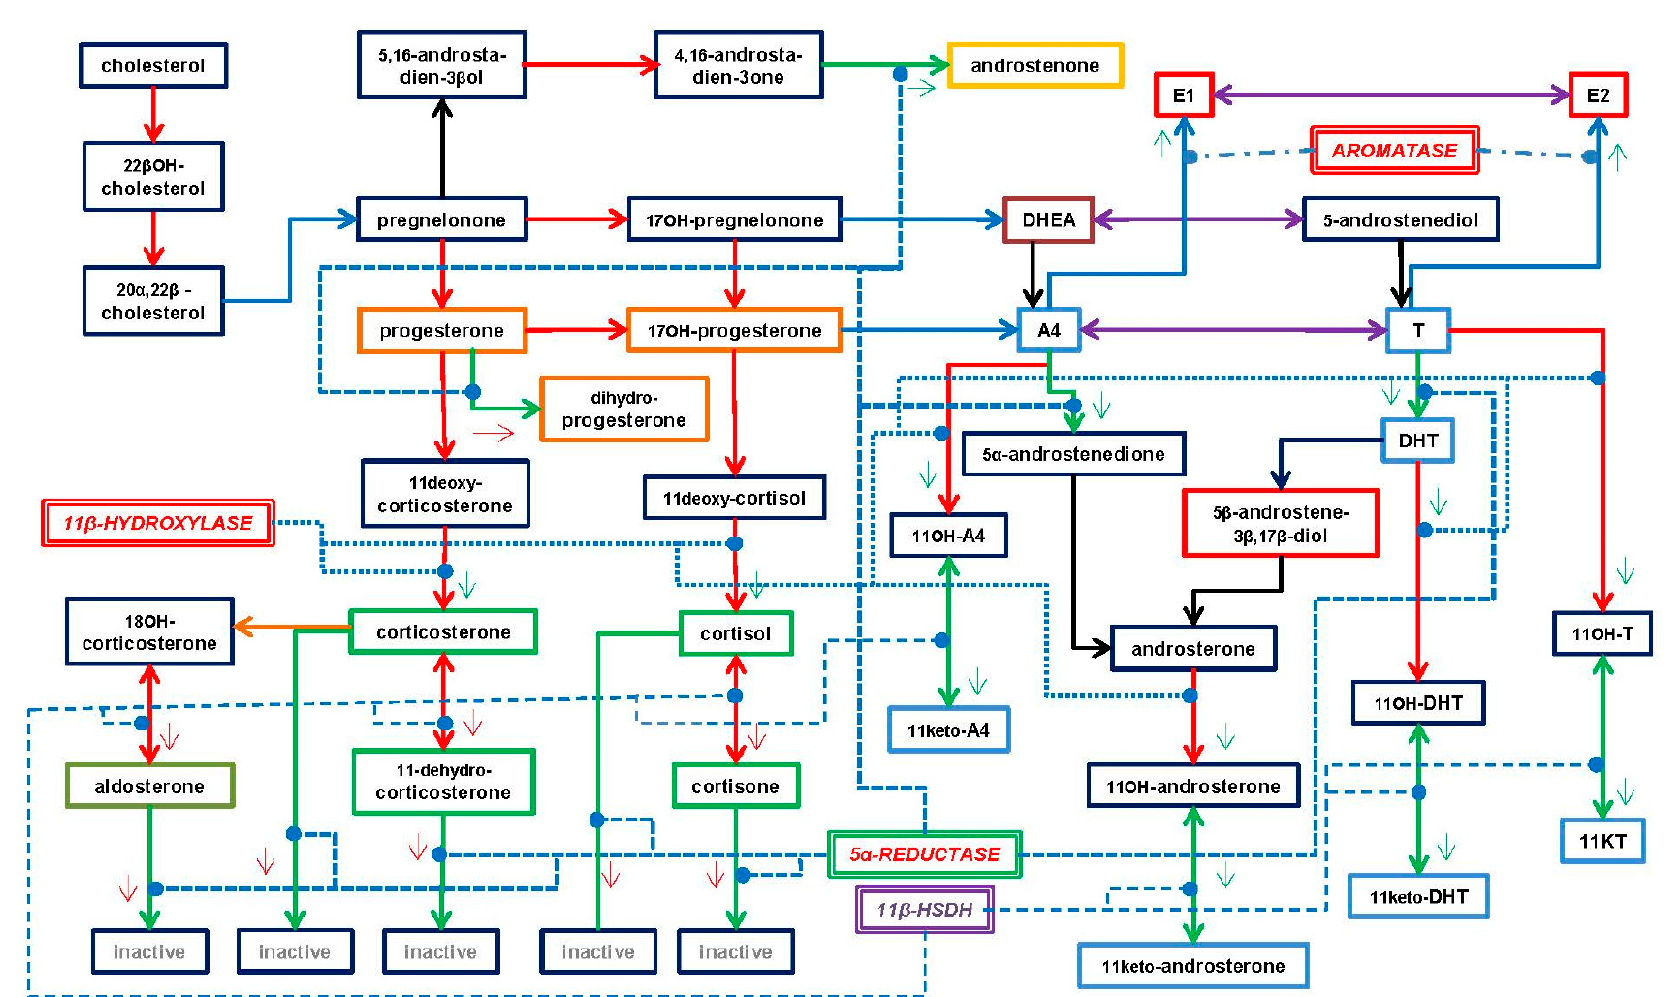
Figure 4. Main shared enzyme activities in the control of glucocorticoid and androgen metabolism in the adrenal gland. Critical role of four key enzymes: aromatase, 5 α -reductase, 11 β -hydroxylase and 11 β -hydroxysteroid dehydrogenase, in the activity and regulation of the main synthesis interrelationships between